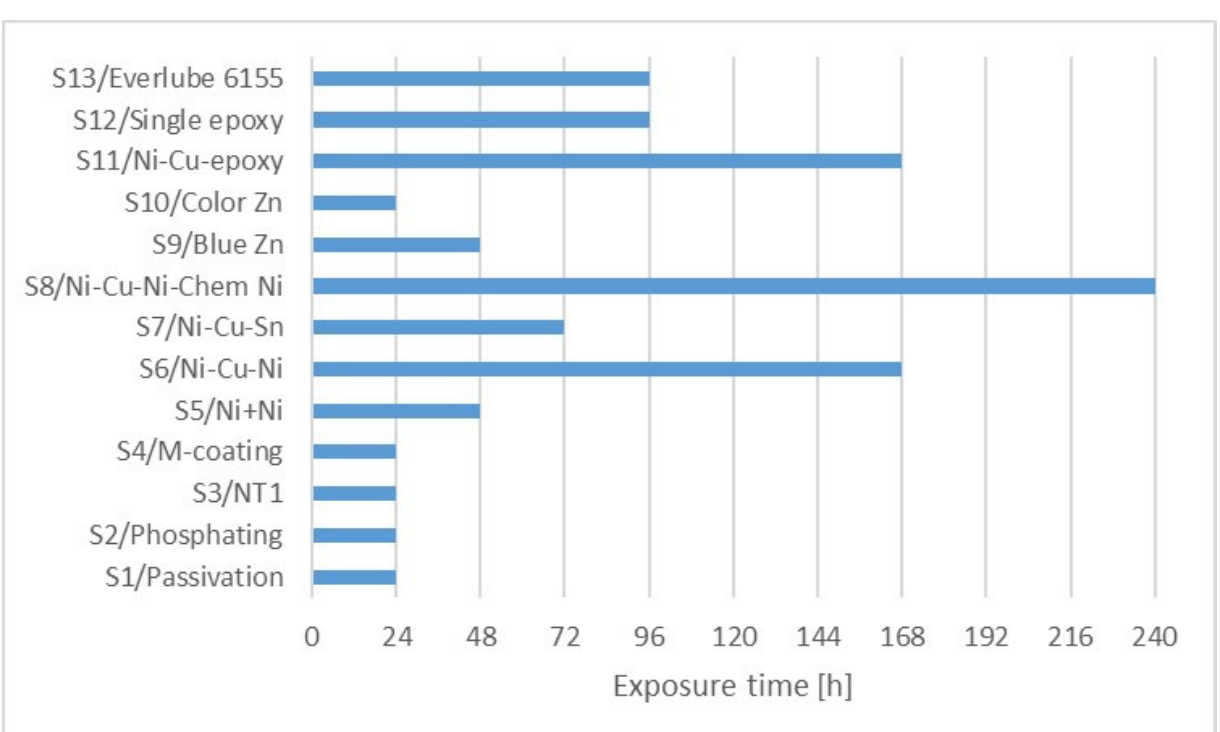
Figure A3. Start of visually observable corrosion attack.